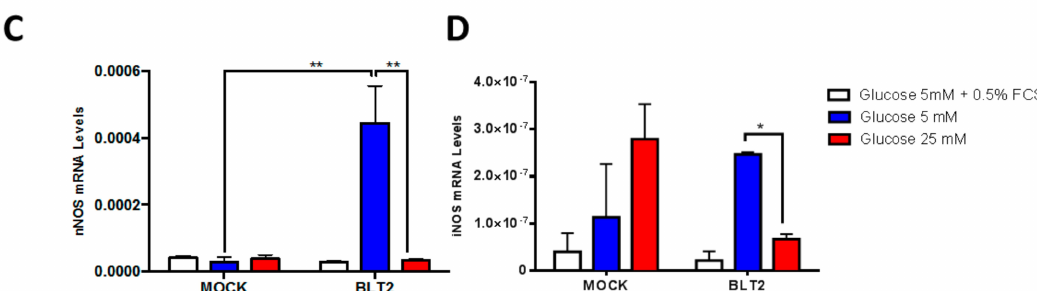
Figure 4. HaCaT-BLT2 cells exhibit higher NO production and nNOS expression levels. Nitric oxide measurement by: ( A ) DAF-2DA; and ( B ) Griess reaction after 48 h of low or high glucose levels. The 100 µ M NONOate and 100 µ M L-NAME were used as positive and negative controls, respectively. ( C ) Q-PCR for nNOS; and ( D ) Q-PCR for iNOS after 48 h. Data represent mean ± SEM, of n = 3 independent